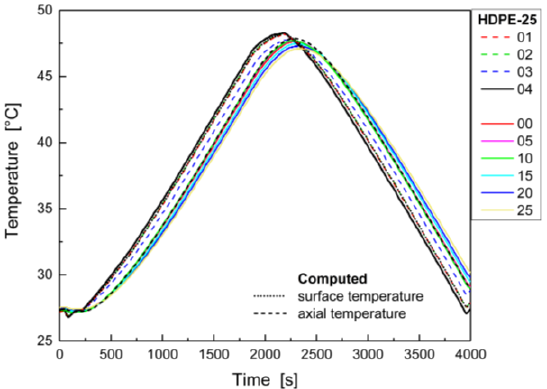
Figure 24. Time-history of measured temperatures and computed surface and axial temperatures (measurement B — temperature increase in climate chamber by 25 °C/probe 2).